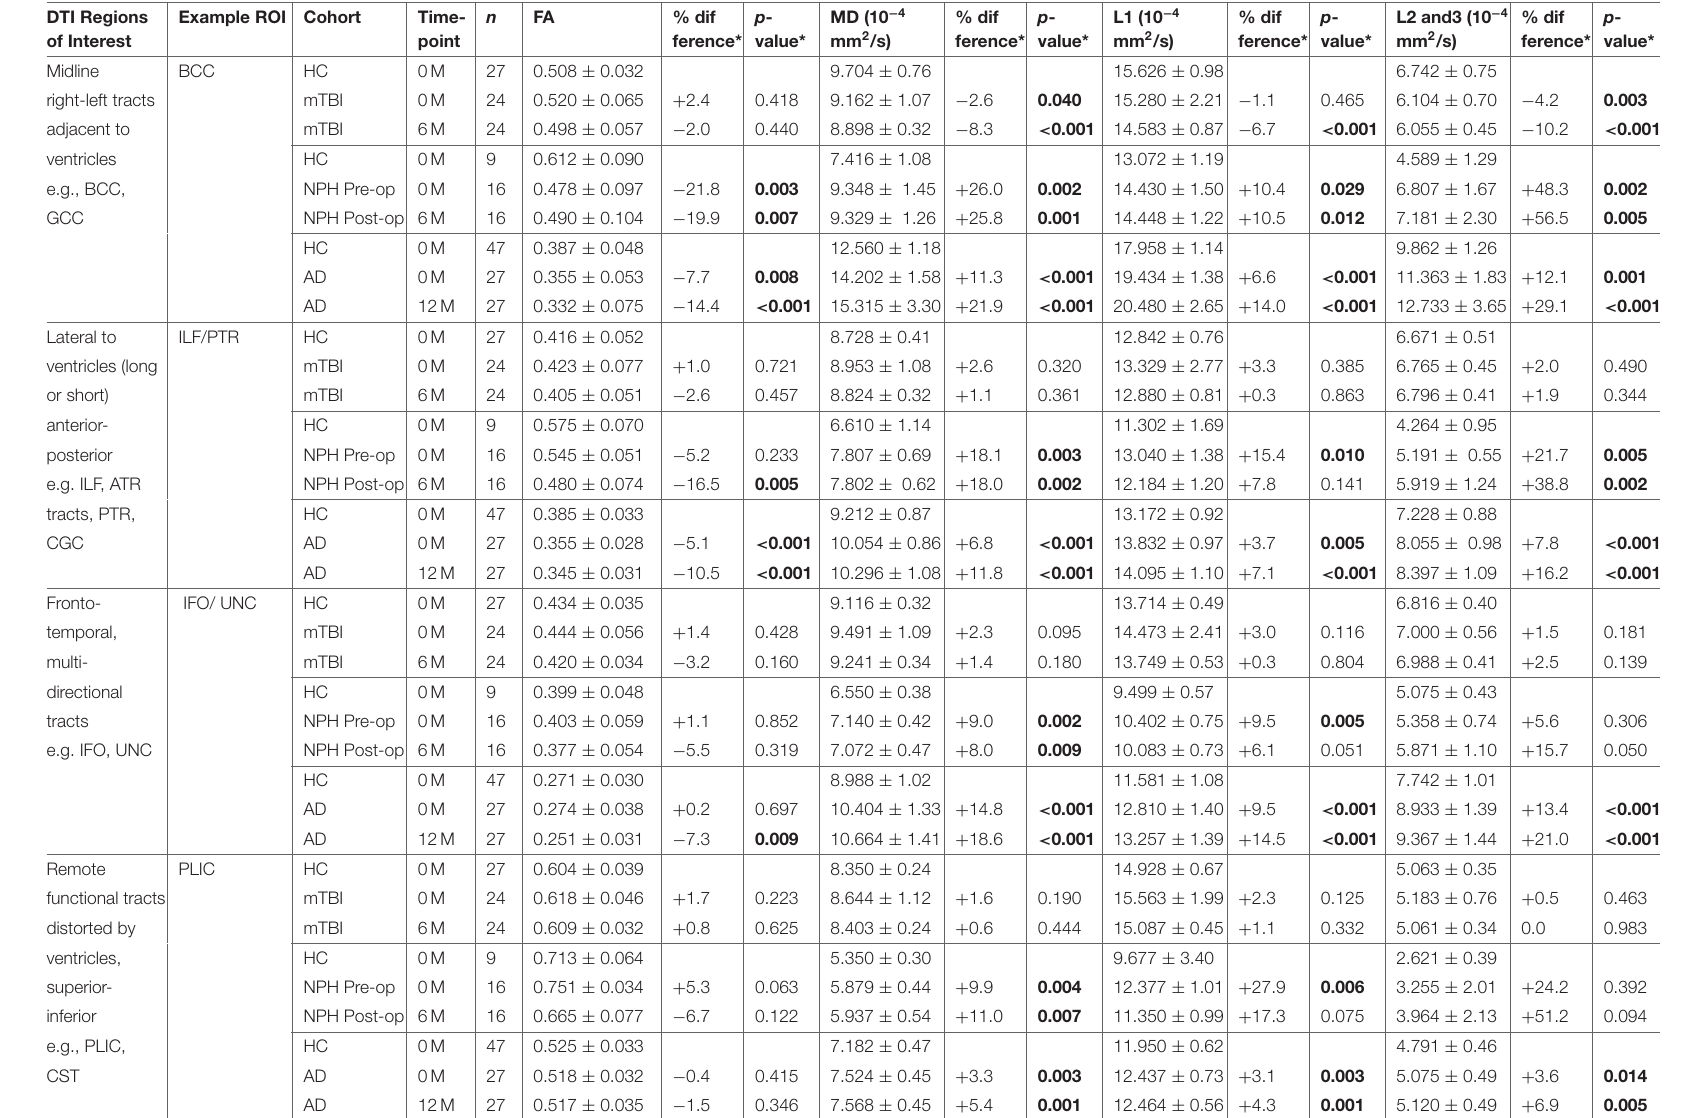
TABLE 2 | Comparison of example DTI region of interest values between clinical cohorts and healthy